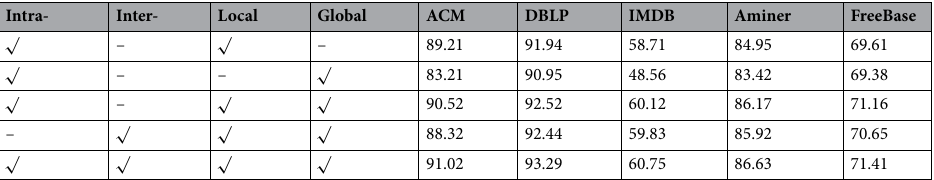
Table 4. Ablation study of pretext tasks on node classification where the intra- and inter- are abbreviations of intra-metapath and inter-metapath contrasts, and local and global indicate node-node and node-graph contrasts,